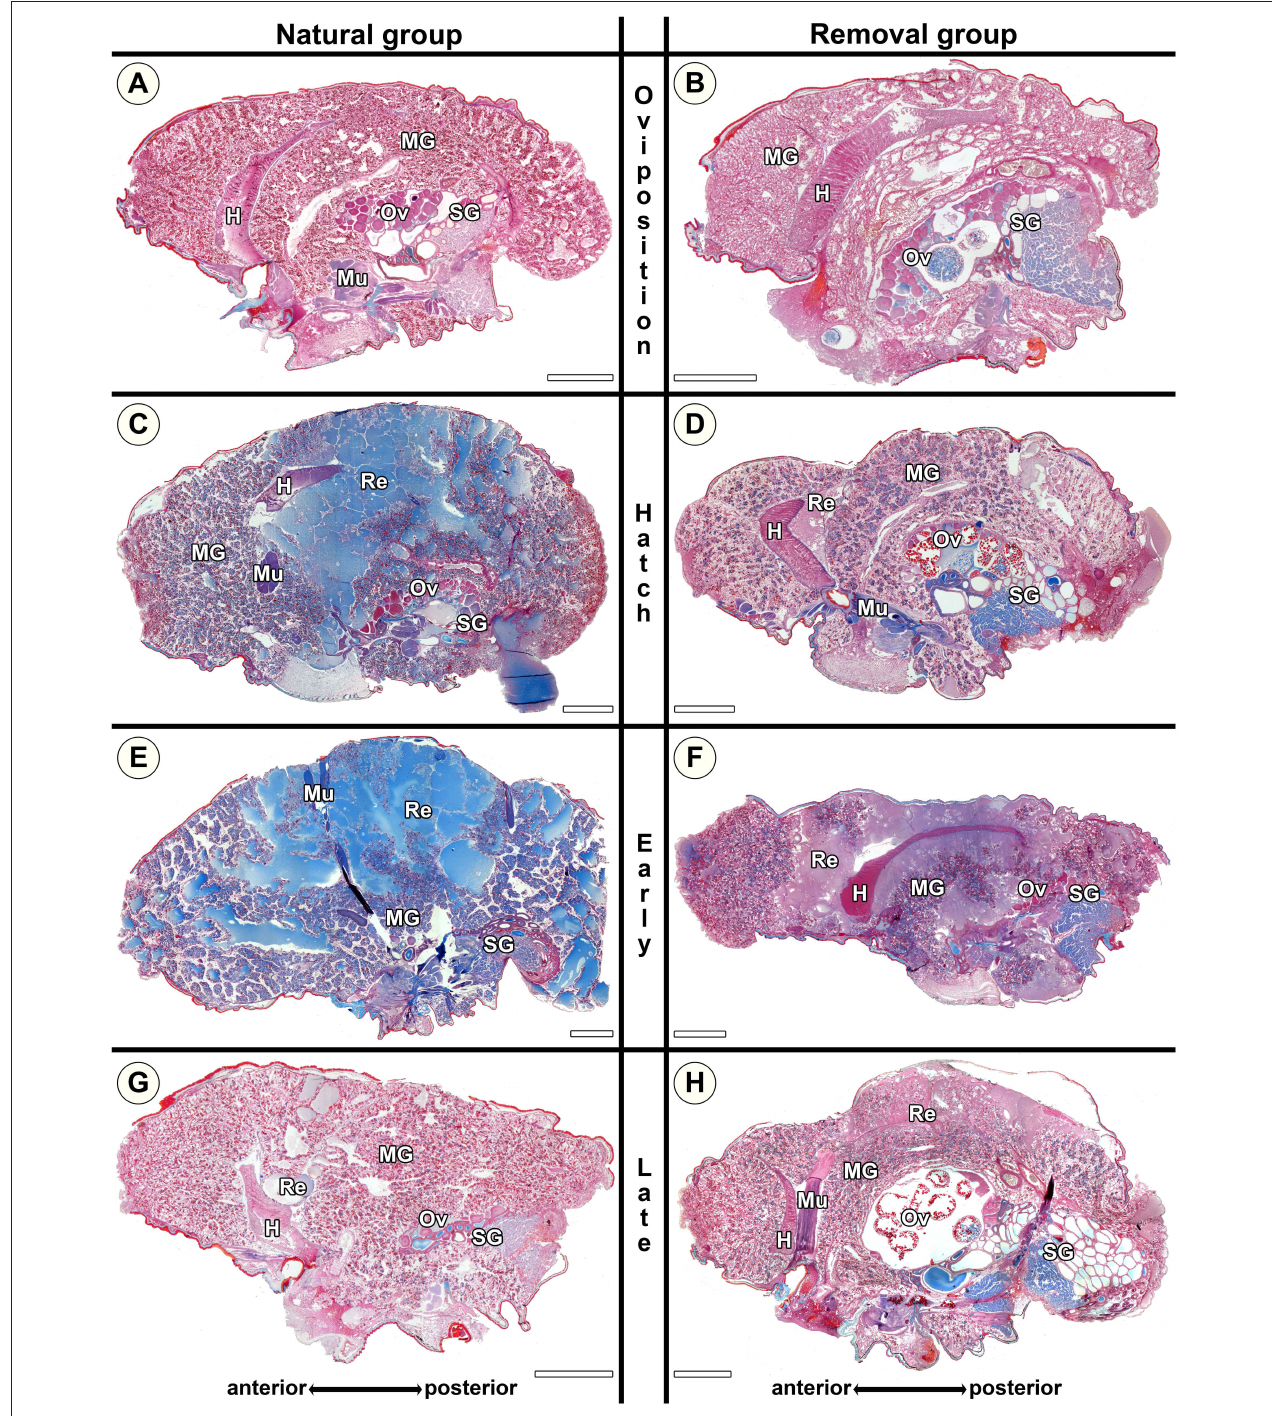
FIGURE 6 | Histological sections of opisthosomata of Stegodyphus lineatus mothers of the natural group (left column) and mothers of the removal group (right column). Females were either chemically fixed (natural group) or the eggs sac or offspring was removed (removal group) at (A,B) oviposition (No, Ro); (C,D) hatching of spiderlings (Nh, Rh); (E,F) early regurgitation phase (Ner, Re; 5 days after hatching); (G,H) late regurgitation phase (Nlr, Rlr; 10 days after hatching). Females in the removal groups were chemically fixed 15 days after hatching of the offspring when matriphagy would occur under natural conditions. In the natural group by the time offspring hatches (C) , massive changes have occurred compared to virgin females or females at oviposition (A) . Blue stained secretion granules are abundant, and parts of the midgut tissue are dissolved with stained extracellular material (Re) accumulating especially in the mid-region of the midgut tissue while anterior parts stay